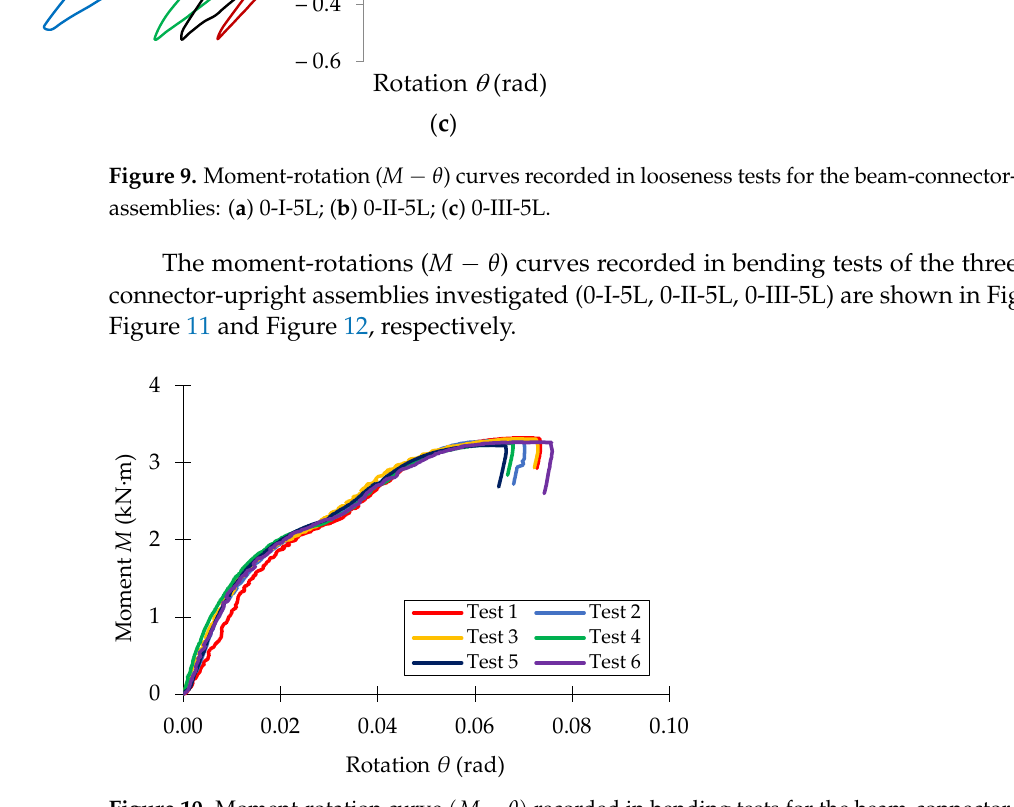
Figure 11. Moment-rotation curve (𝑀 − 𝜃) recorded in bending tests for the beam-connector- upright assembly of type 0-II-5T.